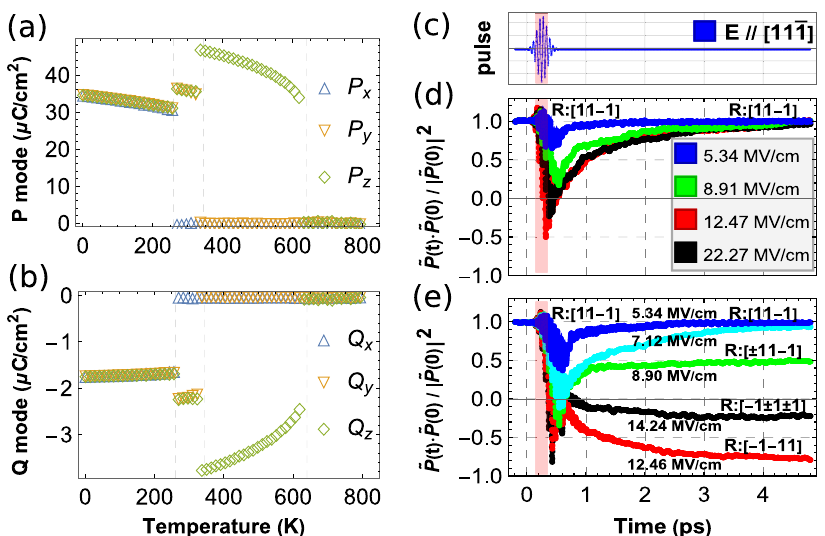
Fig. 1 Results to be compared with experiments. P ( a ) and Q ( b ) modes as a function of temperature. The ratio involving the total polarization at 240 K as a function of time, for partial-excitation ( d ) and full-excitation ( e ) starting from an R-phase. Panel c shares the same horizontal axes with panels d and e to indicate the laser pulse shape and time evolution. Pink regions are to indicate the full-width-half-maximum of the Gaussian enveloped laser